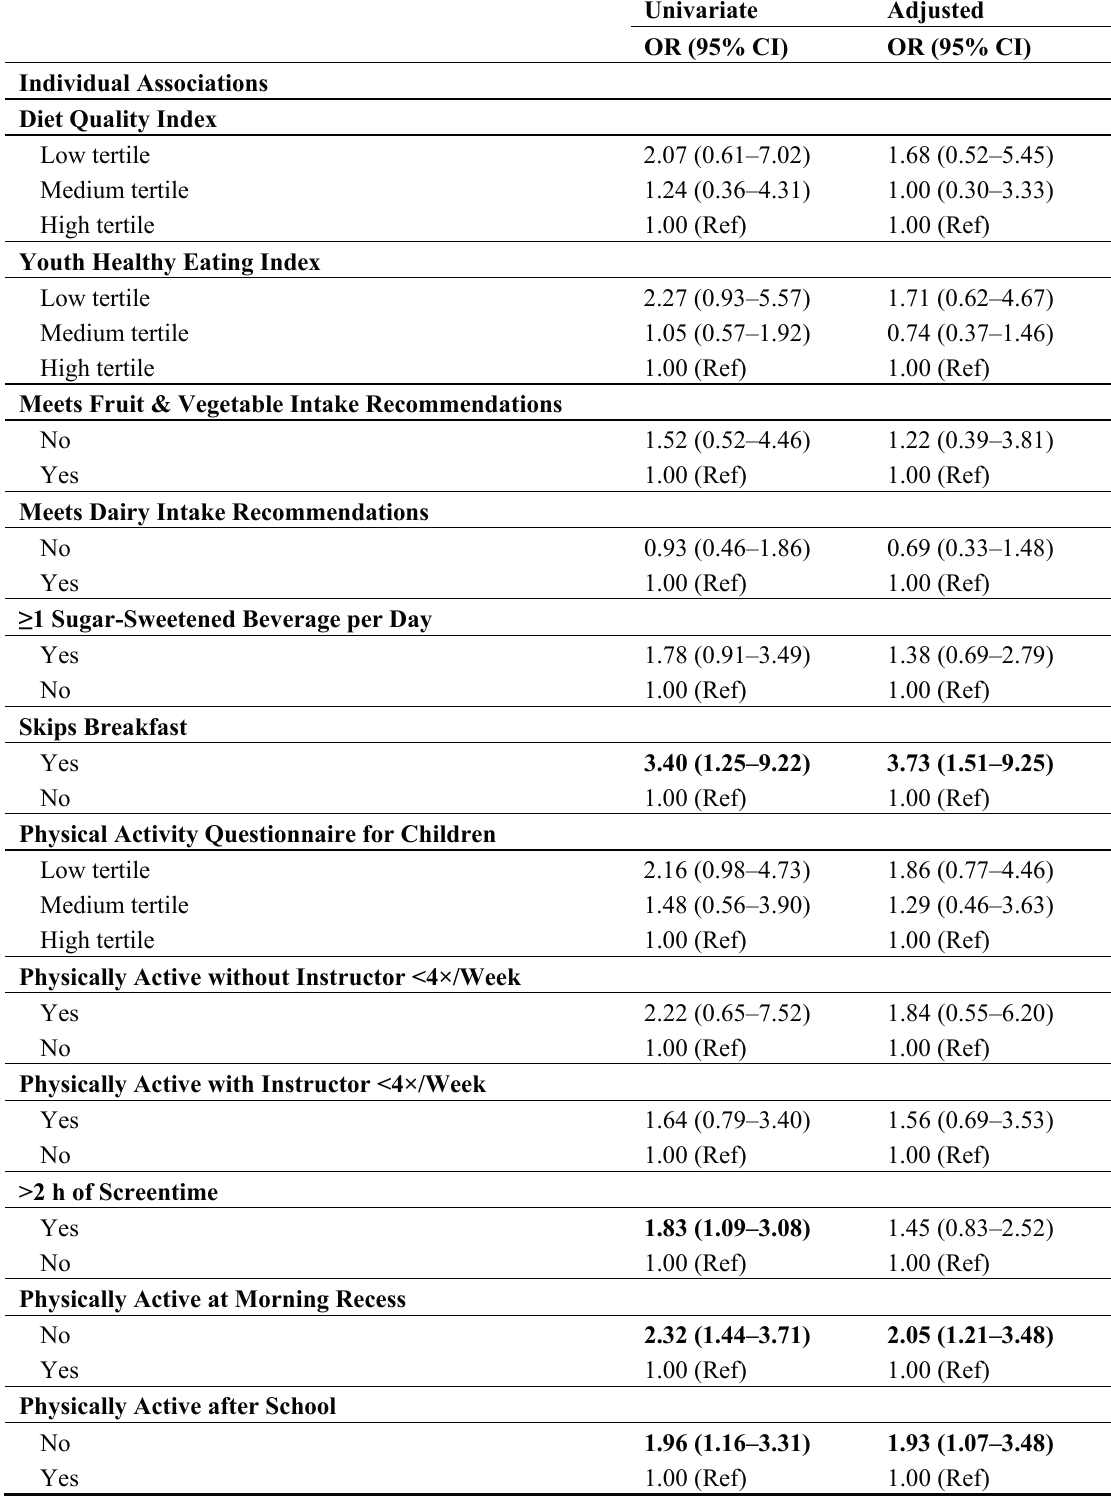
Table 3. Odds ratios (OR) and 95% confidence intervals (CI) for the association between health behaviours and poor academic performance in Mathematics. Models were adjusted for household education and income, models with dietary exposures were further adjusted for energy